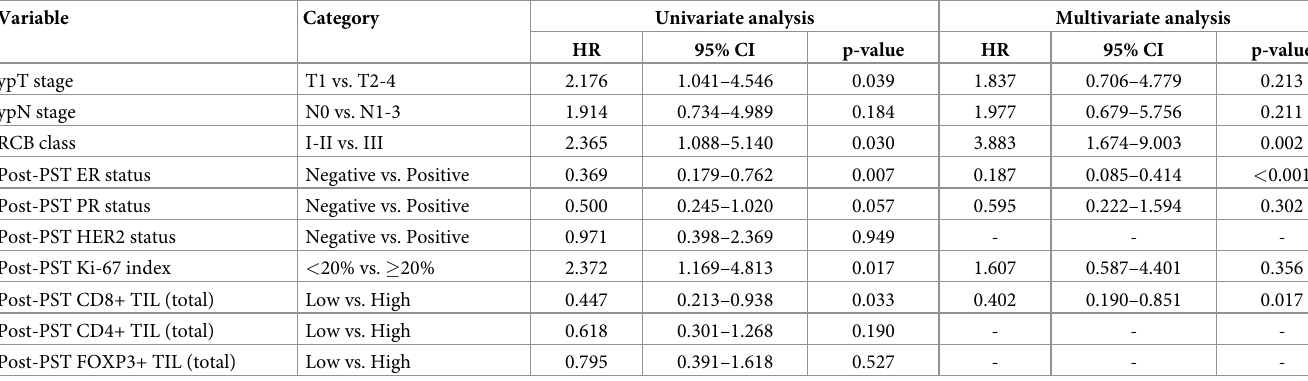
Table 4. Univariate and multivariate analyses of disease-free